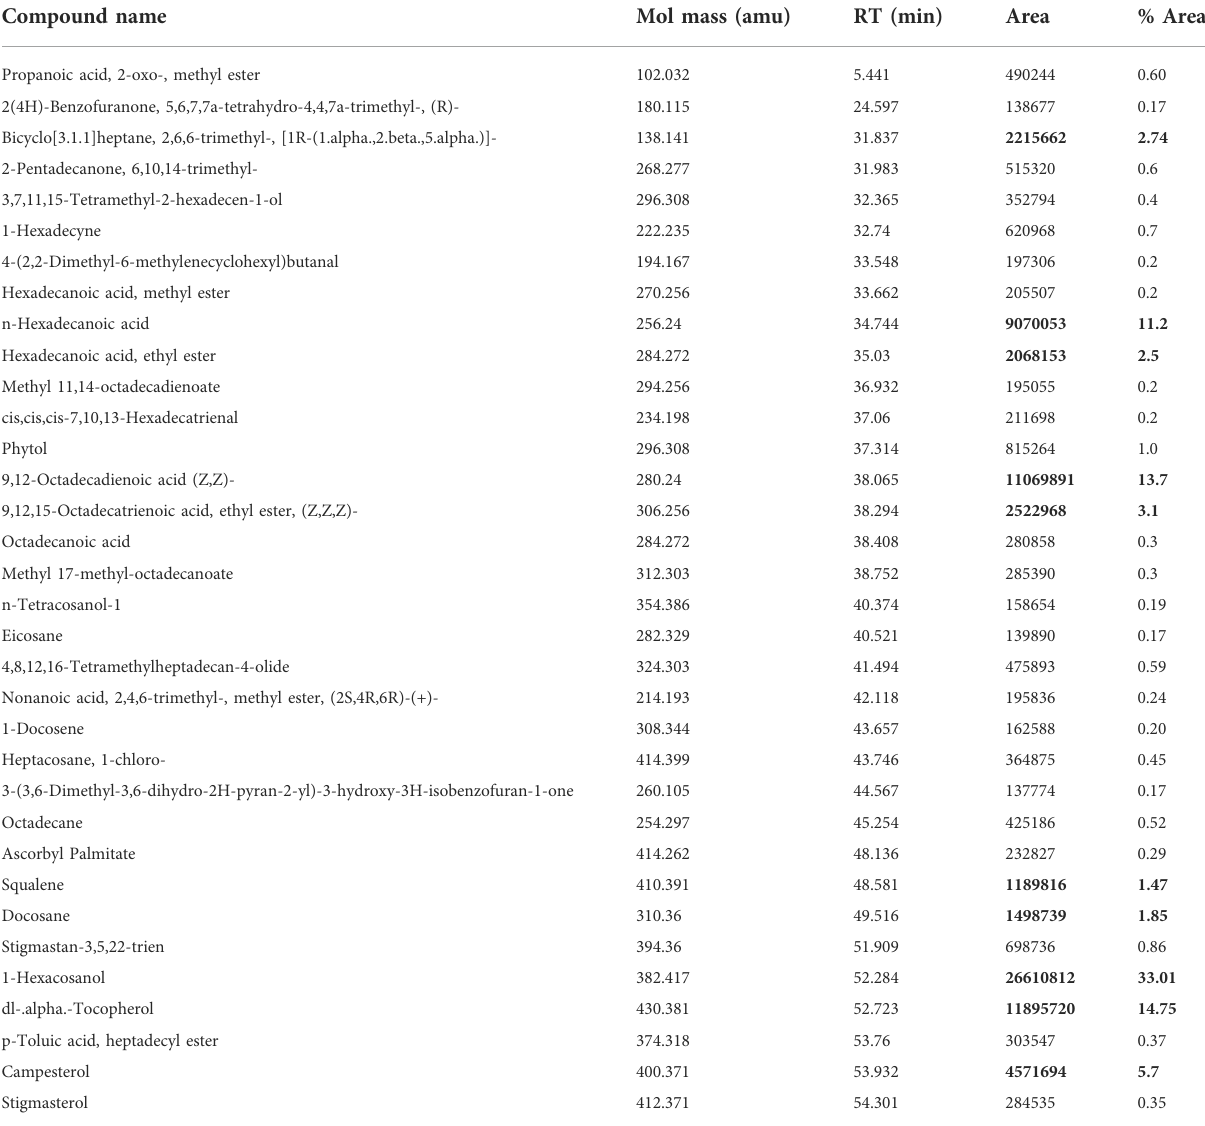
TABLE 1 GC-MS data of ethanol extract of Colligonum comosum l